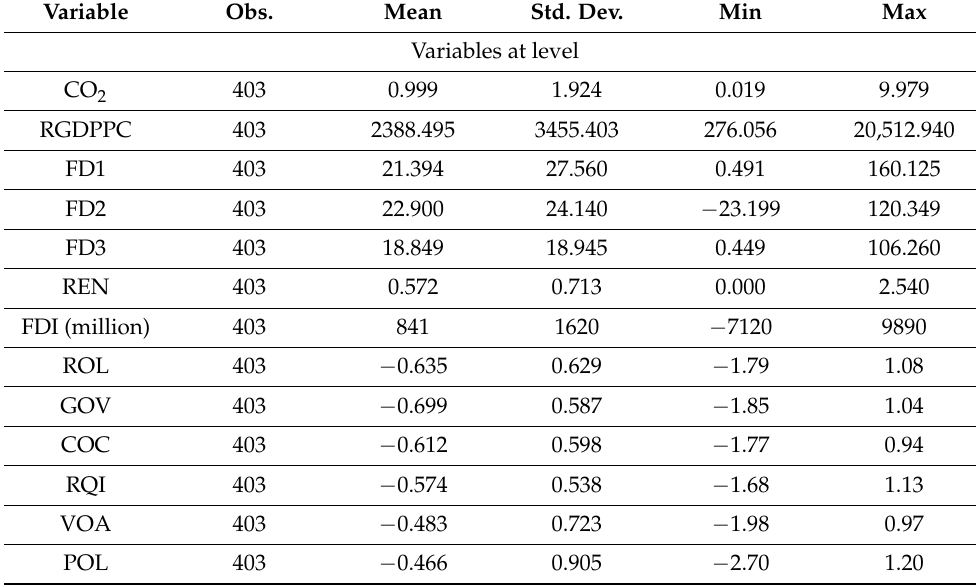
Table 2. Summary